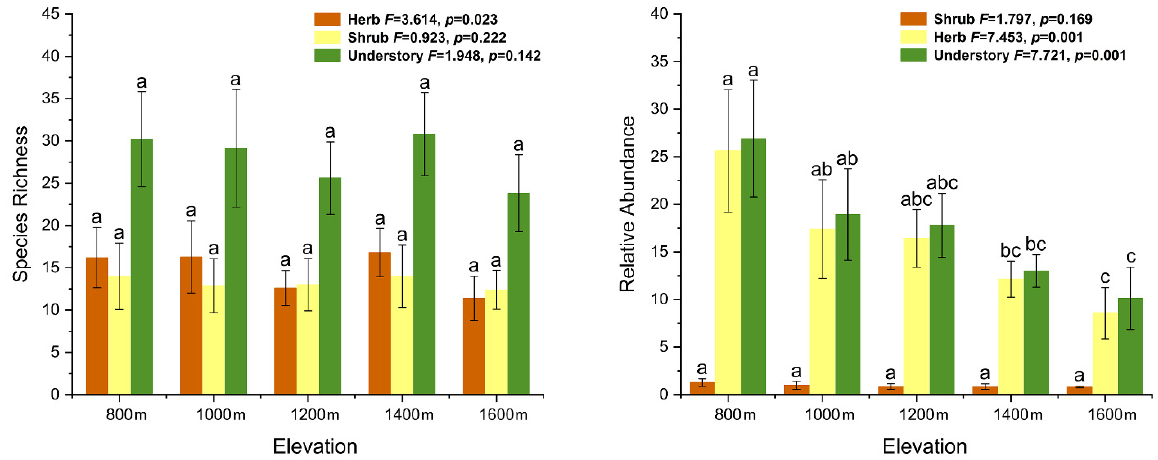
Figure 2. Species richness and relative abundance of understory plants at different elevations. Significant differences ( p < 0.05) among different elevations were indicated by different lowercase letters (ANOVA, Tukey range test). Shrub, shrubby plants (including tree seedlings and vines); understory, shrub and herb .